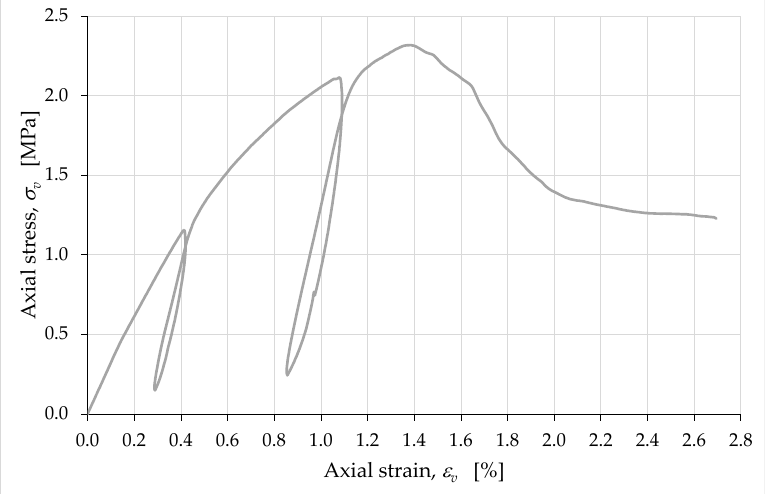
Figure 26. Complete average curve of the axial stress with respect to the axial strain, obtained from the acquisitions of the LVDTs placed between the corners of the metal plates for the distribution of the load.